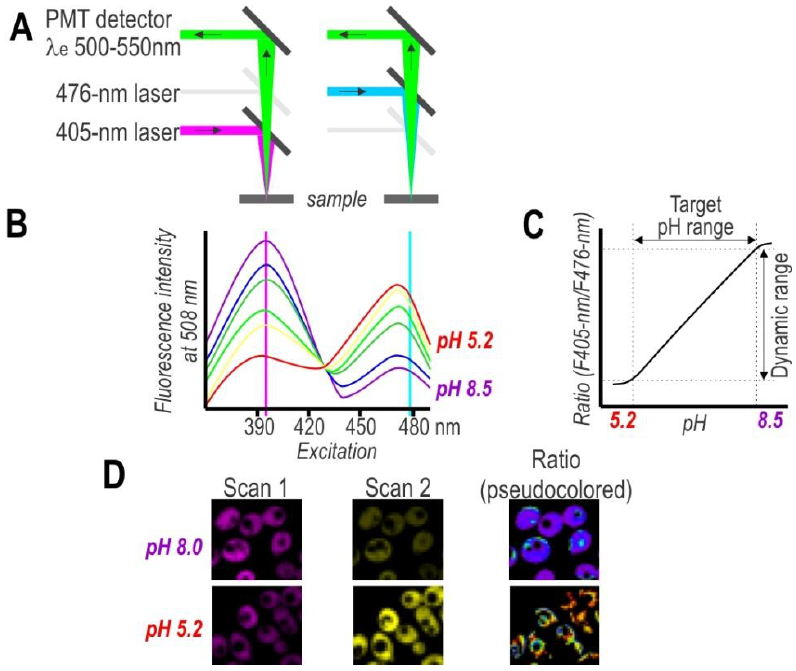
Figure 3. ( A ) A set up of dual excitation sequential scanning confocal microscope for imaging ratiometric pHluorin probes. ( B ) Fluorescence excitation spectra of pHluorin in buffers with pH ranging from 5.2 to 8.5. ( C ) A hypothetical pHluorin dose reponse curve; a plot of fluorescence ratio versus pH. The ratios between the emission intensities at 405- and 476-nm are calculated. The physiological target pH range and physiologically relevant dynamic range are indicated. ( D ) Pseudocolored image (right) of permeabilized yeast cells in buffered solution with nigericin is calculated from images taken at 405- and 476-nm excitation (Scans 1 and 2). Different colors are assigned to defined pH values in accordance with the in situ calibration curve (blue, alkalinic; red, acidic). The in situ calibration curve is shown in panel